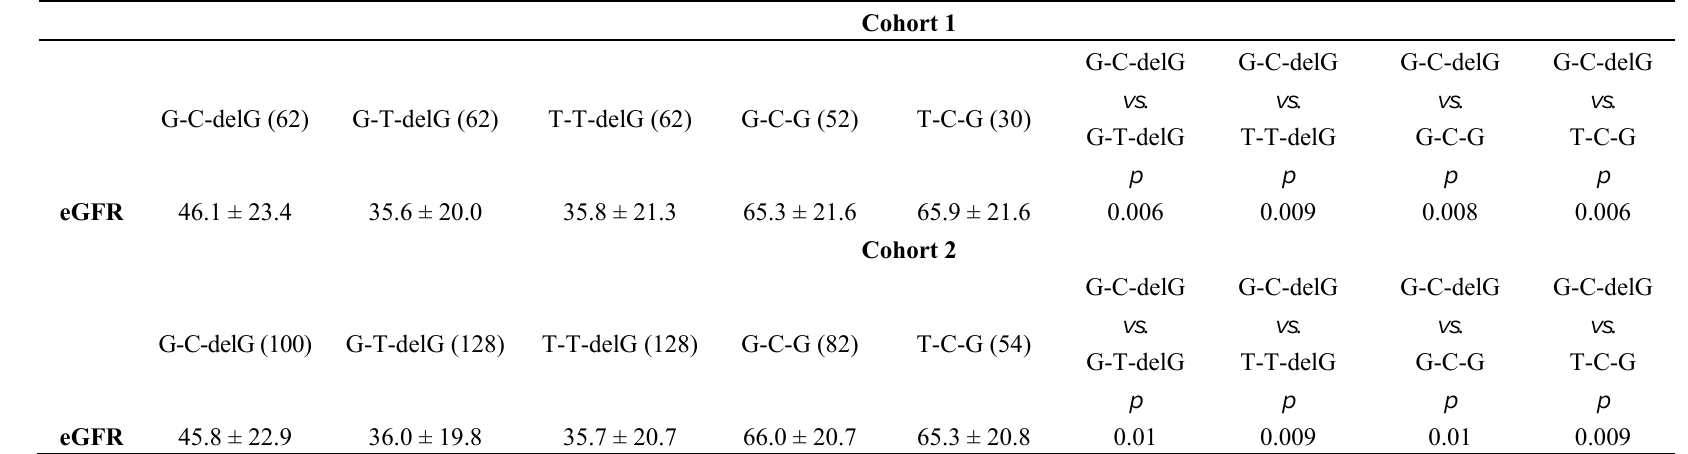
Table 4. The estimated Glomerular Filtration Rate (eGFR) values of study subjects according to Osteopontin ( OPN ) promoter gene